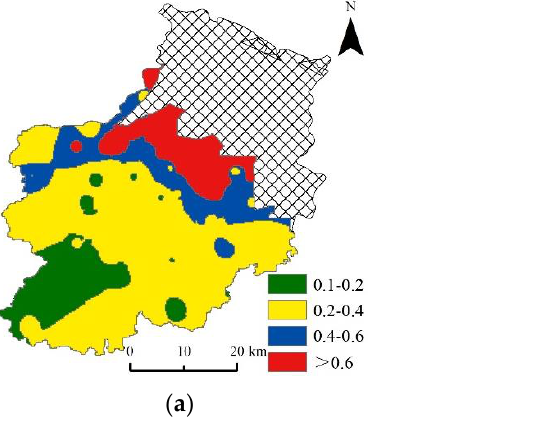
Table 5. Soil area with different degrees of salinization.